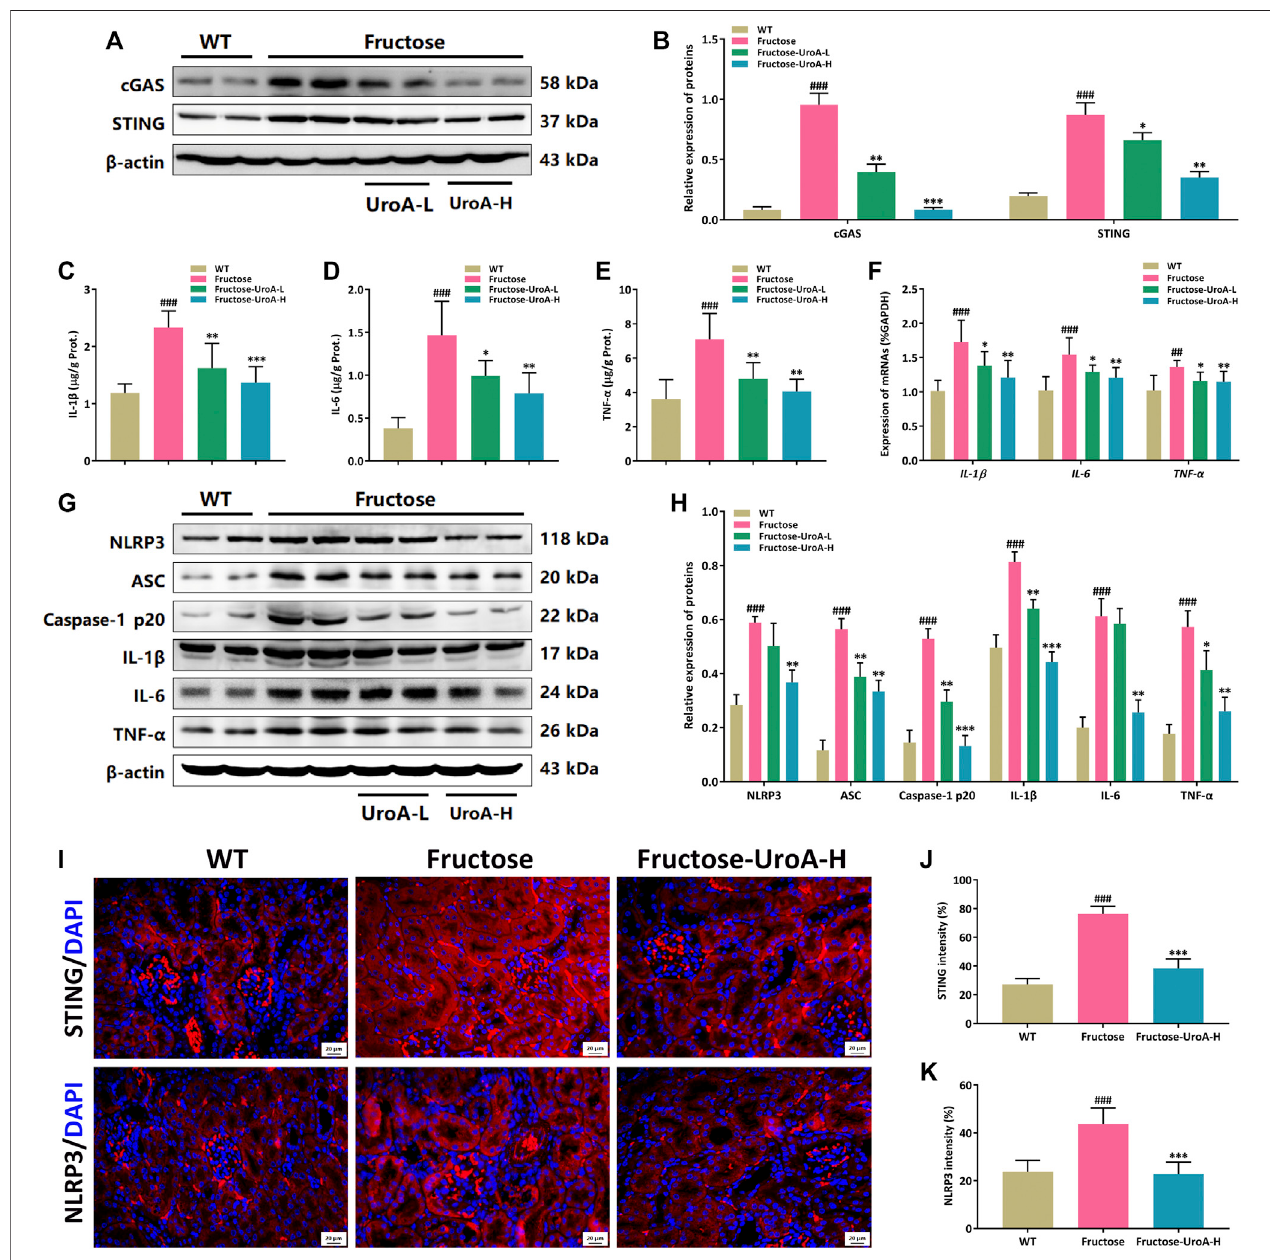
FIGURE 3 | Urolithin A (UroA) impairs STING-NLRP3 axis mediated renal in fl ammatory response in vivo . (A,B) Representative immunoblot images of cGAS and STING protein expression in kidneys (A) and densitometric analysis (B) . (C – E) The level of IL-1 β (C) , IL-6 (D) , and TNF- α (E) in kidney tissues were detected by commercial enzyme-linked immunosorbent assays (ELISA). (F) Histograms show RT-qPCR quanti fi cation of IL-1 β , IL-6, and TNF- α mRNA expression in the kidney tissues from the wild-type (WT) or fructose-fed mice with intragastric administration of either vehicle or UroA, respectively. The representative immunoblots of NLRP3,ASC,Caspase-1 p20,IL-1 β , IL-6,and TNF- α wereshownin (G) . (H) Histograms show theprotein expression ofNLRP3, ASC,Caspase-1 p20, IL-1 β ,IL-6,and TNF- α quanti fi edthroughthewesternblottingopticalanalysisshownin (G) . β -actinwasusedasaninternal reference. (I) Representativeimages ofimmuno fl uorescence staining of STING and NLRP3 of kidney tissue sections. Original magni fi cation: ×400; Scale bar: 20 μ m. (J,K) Densitometric analysis of STING (J) and NLRP3 (K) . Mean ± S.D., n = 8 for RT-qPCR quanti fi cation analysis and n = 5 for kidney protein expression analysis. ## p < 0.01, ### p < 0.001 versus the WT group; * p < 0.05, ** p < 0.01, *** p < 0.001 versus the fructose group. UroA-L and UroA-H represent intragastric administration of urolithin A at low (50 mg/kg/day) and high (100 mg/kg/day) doses, respectively. Prot.: protein.